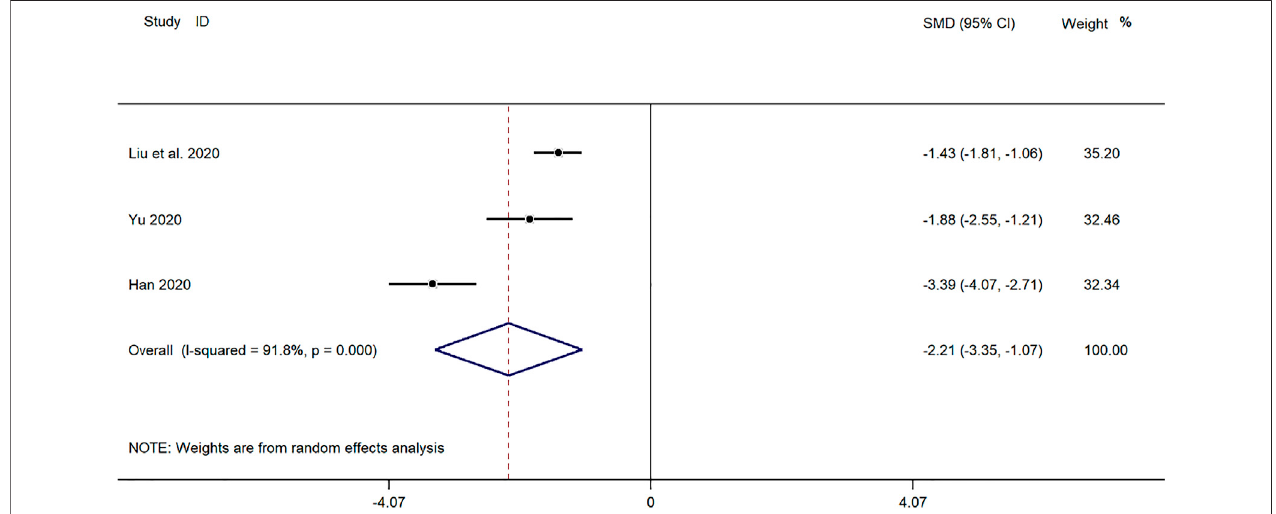
FIGURE 6 | Meta-analysis of forest plots comparing the time for disappearance of lung rales in the experimental and control group.